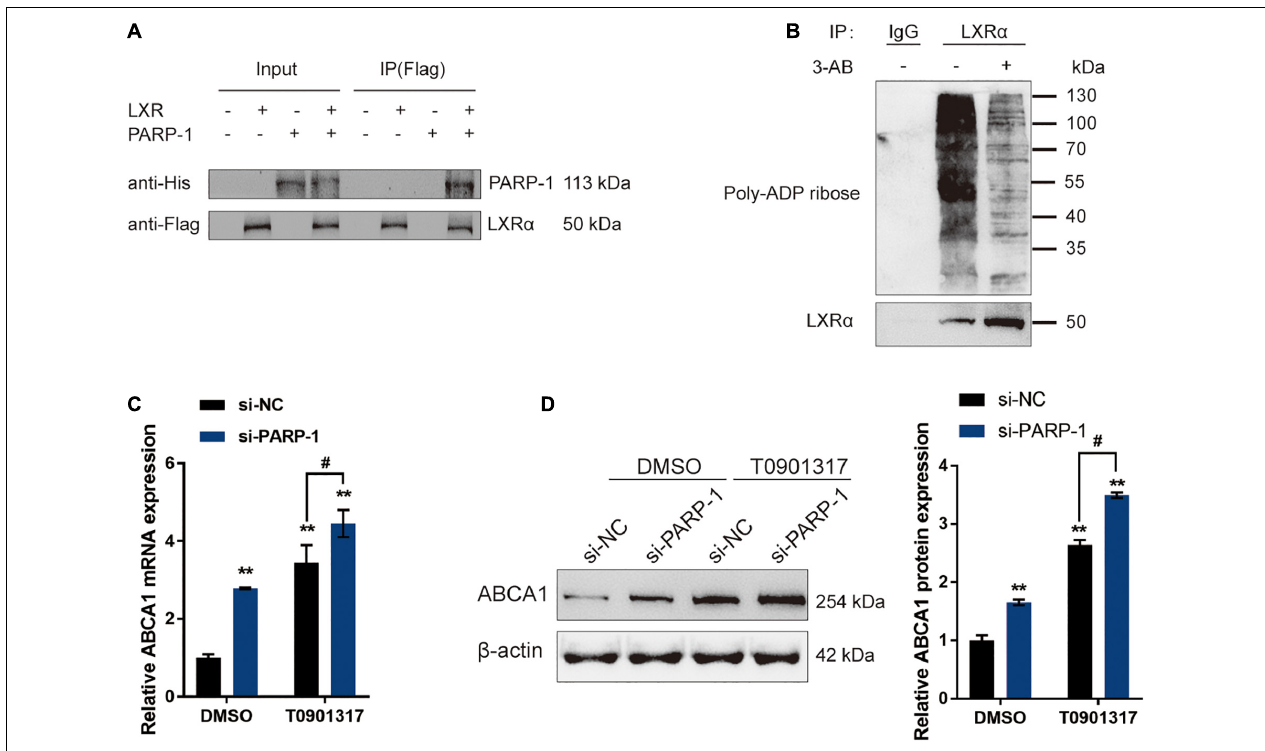
FIGURE 5 | PARP-1 inhibits LXR-induced ABCA1 transcription in INS-1 cells. (A) Confirmation of the interaction between LXR and PARP-1 in INS-1 cells using coimmunoprecipitation (Co-IP) assay. (B) LXR α poly(ADP-ribosyl)ation was detected in INS-1 by Poly(ADP-ribosyl)ation Assay. (C,D) INS-1 cells were transfected with si-PARP-1 in the presence or absence of LXR receptor agonist T0901317 and examined for the mRNA expression and protein levels of ABCA1 by real-time PCR and immunoblotting. n = 3 for each experiment. ** P < 0.01 compared with the si-NC + DMSO group, # P < 0.05 compared with the si-NC + T0901317